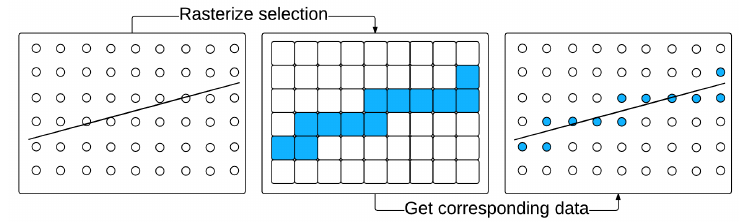
Figure 3. Rasterization of a user-input trajectory of interest on the Earth’s Surface.